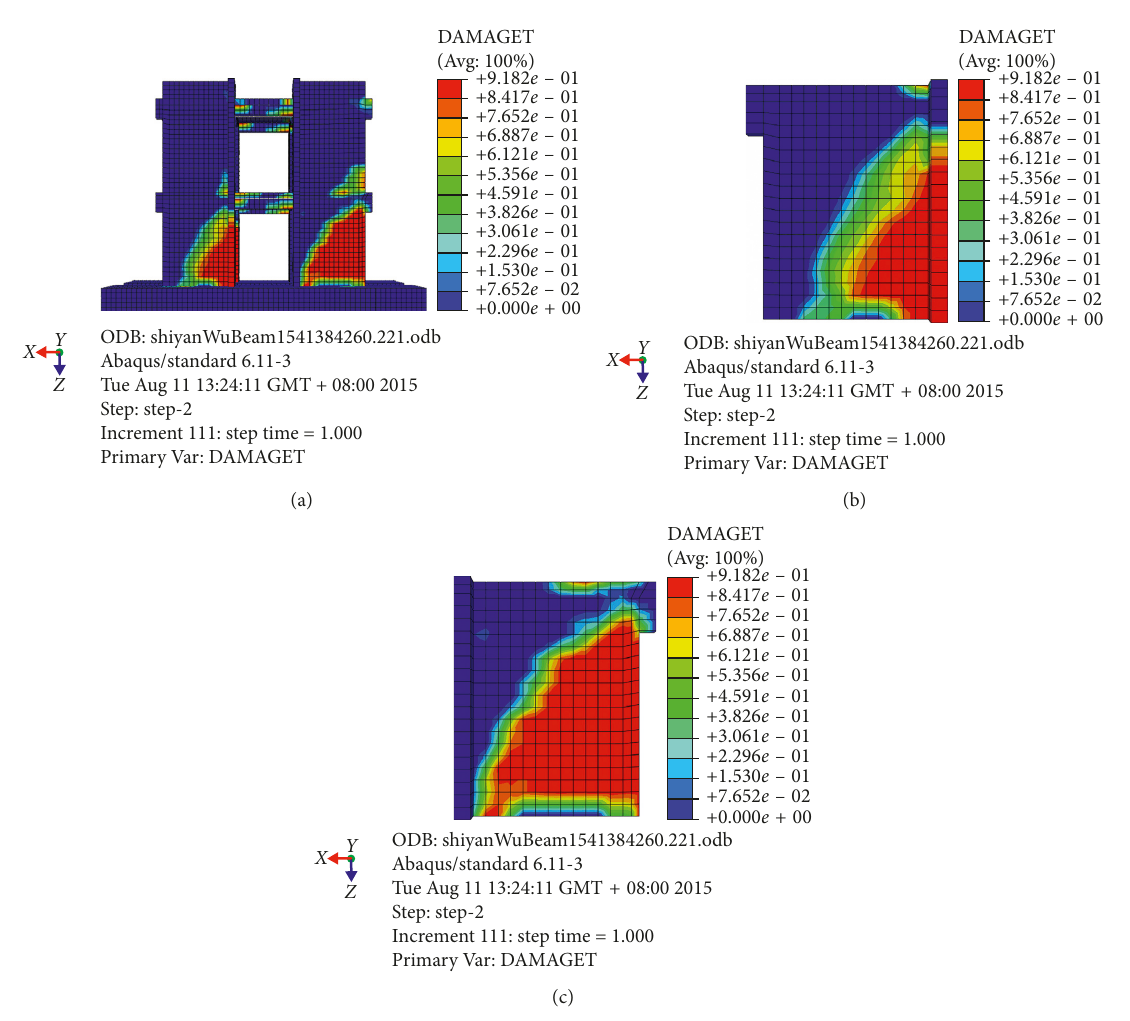
Figure 21: Concrete tensile damage ratio distribution of the NPGCS spatial model. (a) Concrete tensile damage ratio distribution of the whole NPGCS spatial model. (b) Concrete tensile damage ratio distribution on the 1st floor web compressive panel of the whole NPGCS spatial model. (c) Concrete tensile damage ratio distribution on the 1st floor flange compressive panel of the whole NPGCS spatial